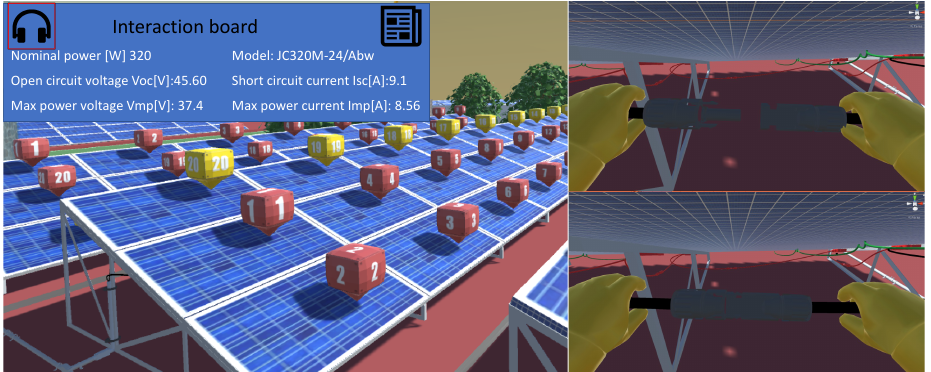
Figure 4. Connecting PVs and inspecting